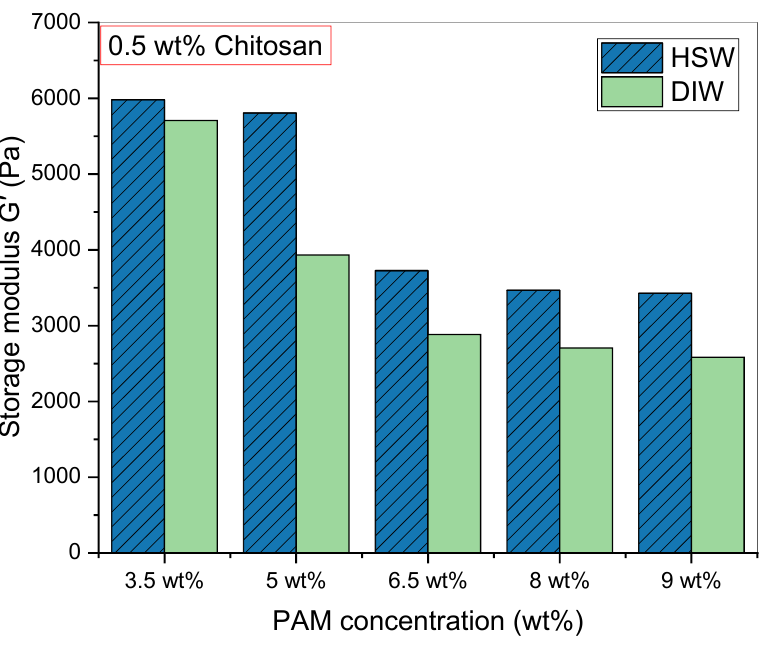
Figure 10. The effect of PAM concentration (3.5–9 wt%) on storage modulus (G’) in DIW and HSW.